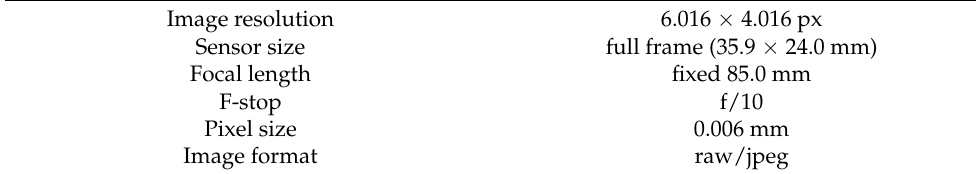
Table 2. Camera parameters. Source: The Nikon D750 manual.